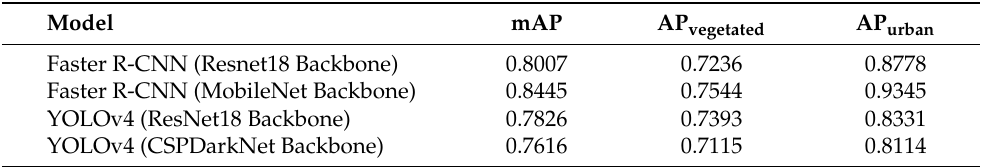
Table 3. Quantitative Testing Results for the Different Variants of Computer Vision Object Detection Models Implemented for Floodborne Object Type